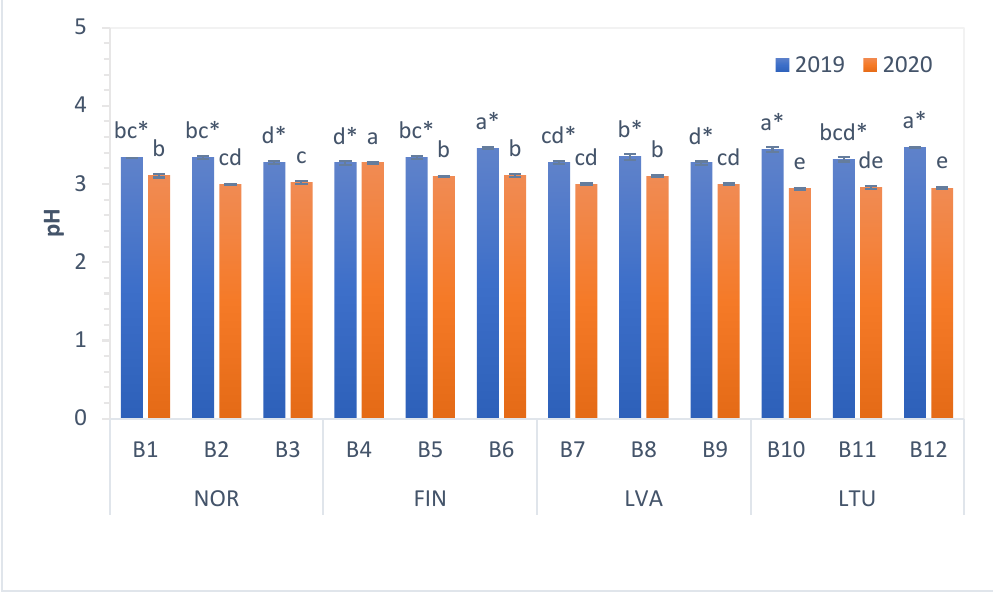
Figure 1. pH values of bilberries. Values are presented as means ± standard deviations. Different letters within the same column indicate significant differences between the collection locations (B1– B12) ( p < 0.05). Significant differences between 2019 and 2020 are indicated by asterisks (*) ( p < 0.05). Locations of bilberry sample collection include Norway (NOR), Finland (FIN), Latvia (LVA) and Lithuania (LTU).